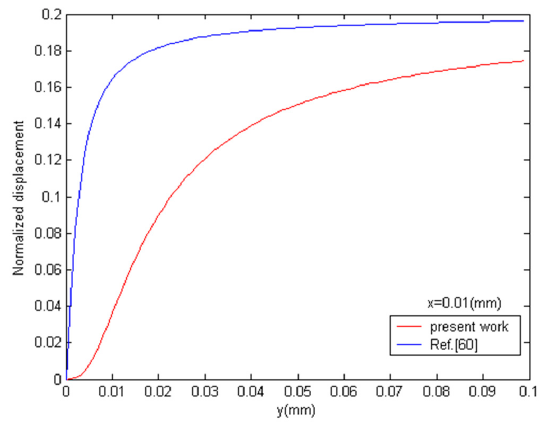
(cid:107) with y ( x = 3